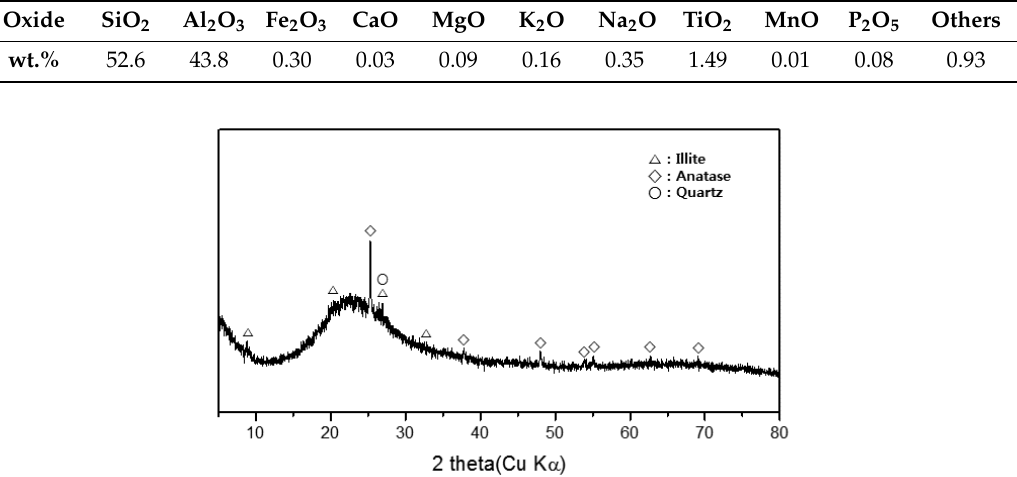
Figure 2. X-ray diffraction pattern of the metakaolin used in this study. It contains crystalline phases such as illite (an aluminosilicate), anatase and quartz (crystalline silica). Table 2. Content of the major elements in the metakaolin used in this study, as determined by X-ray diffraction (XRD).